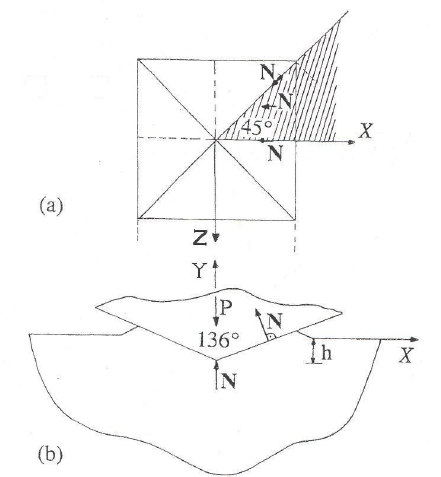
Figura 2: Rappresentazione schematica di un test di durezza eseguito utilizzando un penetratore di tipo Vickers. Figure 2: Schematic sketch of a Vickers